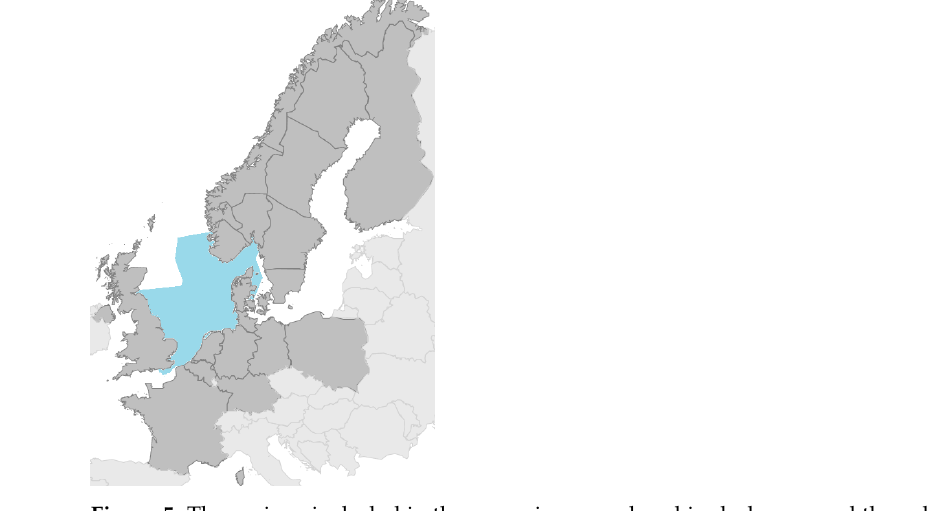
Figure 5. The regions included in the scenarios are colored in dark gray and the colored blue area shows what we consider to be part of the North